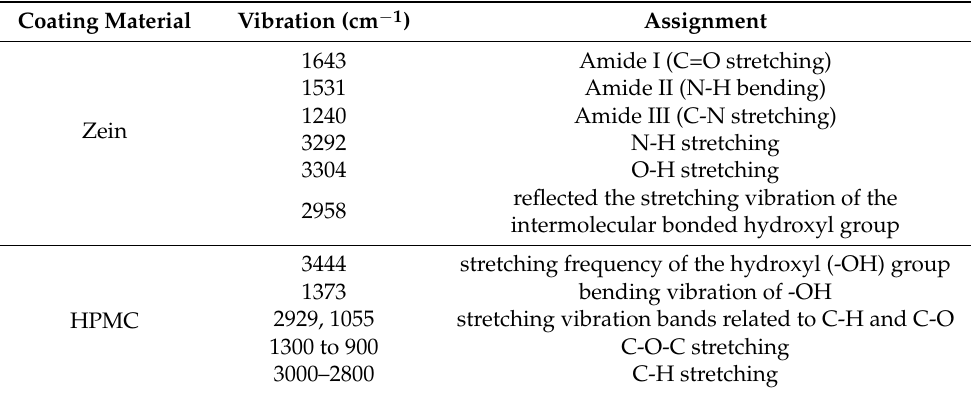
Figure 6. FTIR spectrum of zein (Z)-black line; HPMC—red line; and rosemary extract—blue line. Table 6. FTIR bands of zein and HPMC with assignments.